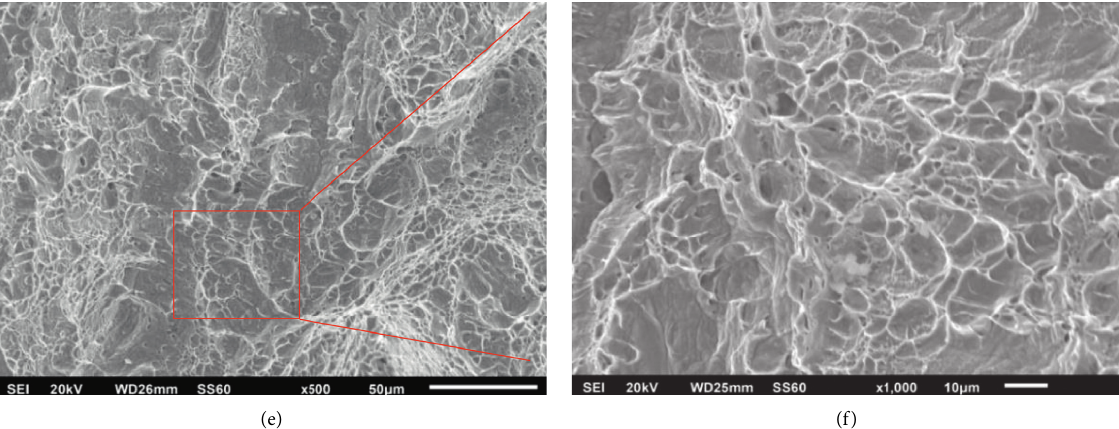
Figure 12: Impact fracture morphology in the crack healing area at different values of FR. (a, b) FR of 1.8. (c, d) FR of 2.0. (e, f) FR of